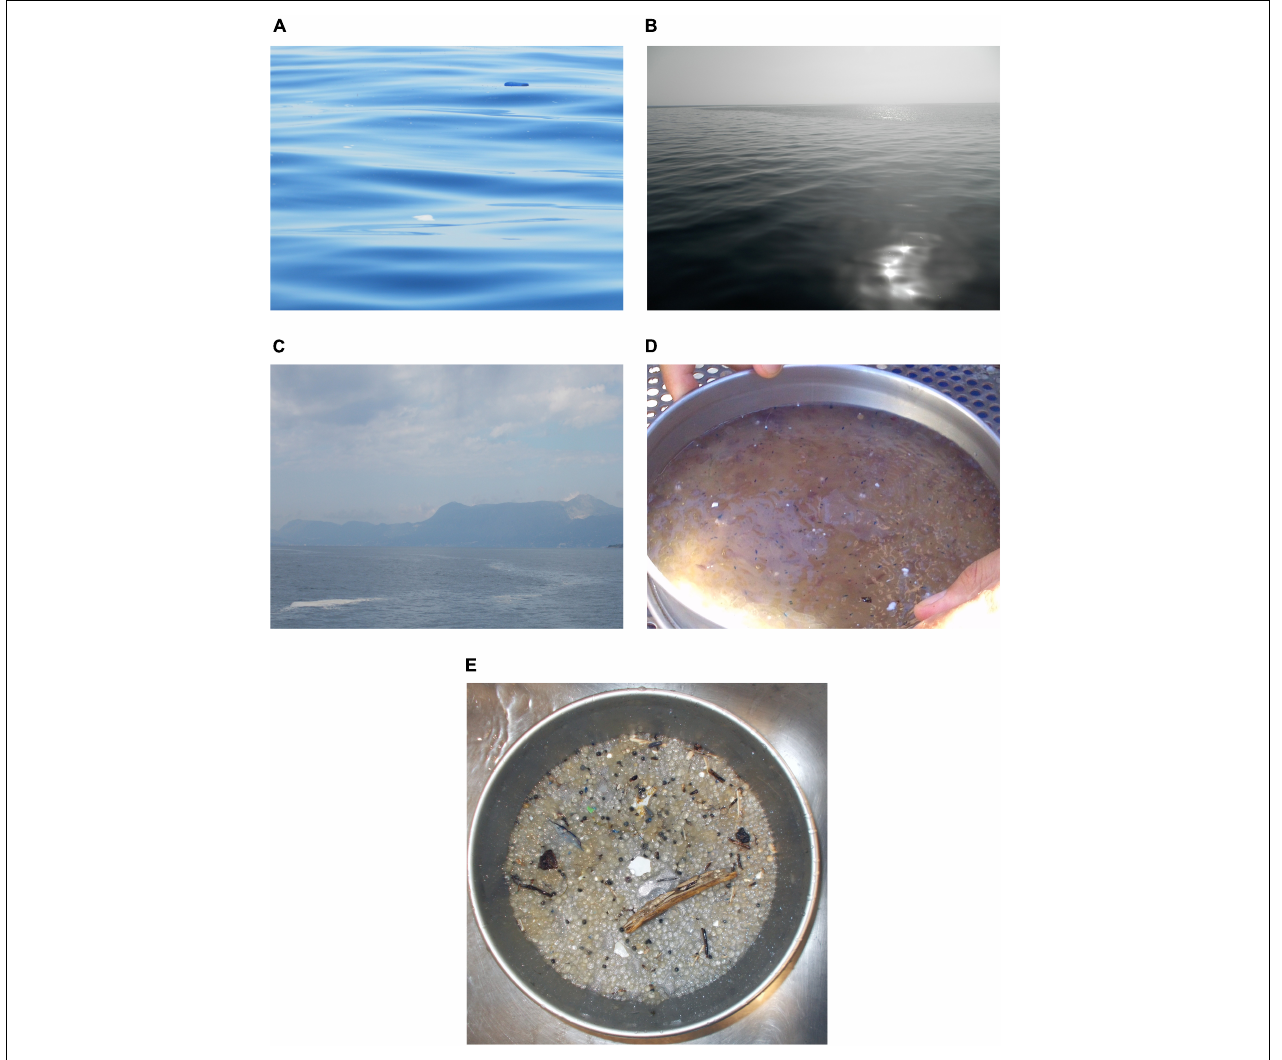
FIGURE 3 | Slick appearance of the sea surface on 9/10/2014 in the N. Ionian Sea (sample 10-1M) with apparent floating macroplastics (A) ; on 14/10 2014 in Corfu Gulf (sample 10-13M) (B) ; on 25/4 2015 in Corfu Gulf with apparent formation of windrow (sample 4-15M) (C) ; gelatinous zooplankton in sample 10-1M (D) ; fish eggs in sample 10-7M (E)